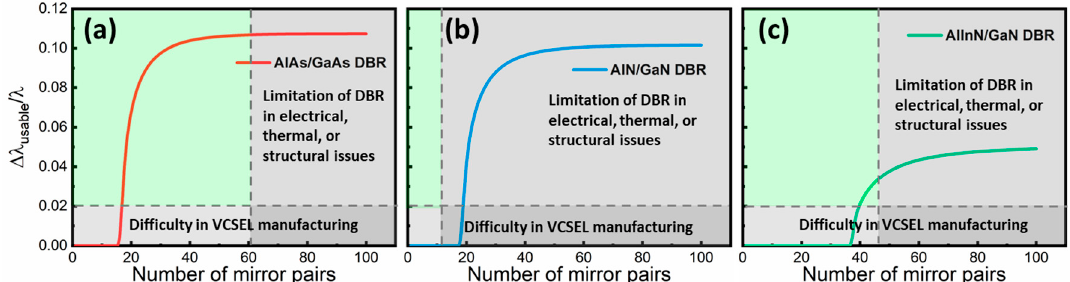
Figure 4. A plot of normalized stop bandwidth, ∆ λ usable / λ , versus the number of DBR pairs for ( a ) AlAs/GaAs DBR, ( b ) AlN/GaN DBR, and ( c ) AlInN/GaN DBR. The normalized stop bandwidth for selected material systems is also labeled.